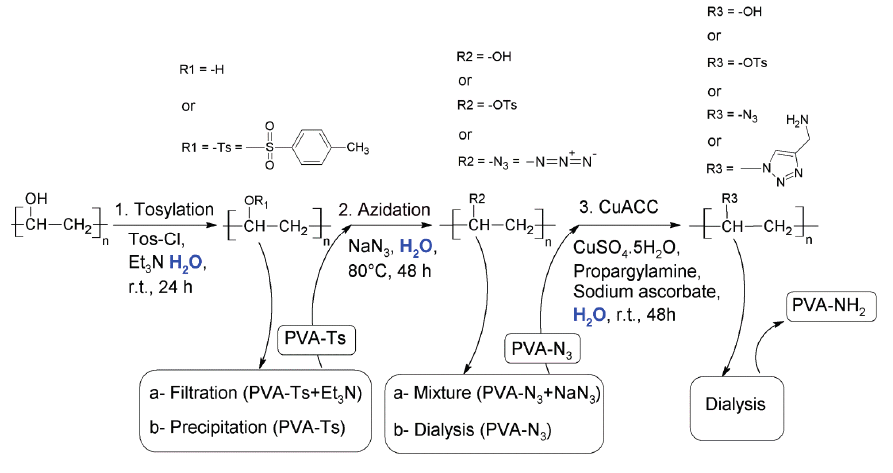
Figure 1. Synthetic strategy using for polyvinyl alcohol (PVA) modification in